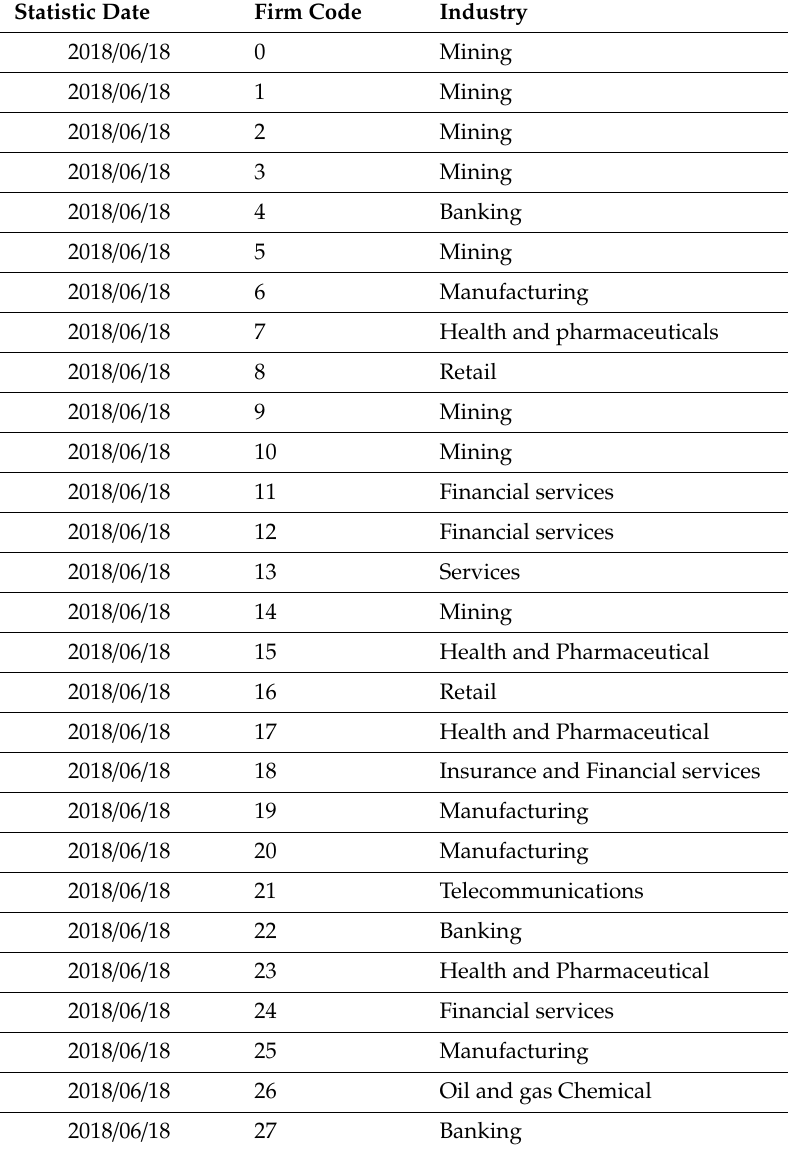
Table 1. List of firms listed on the FTSE / JSE Responsible Investment